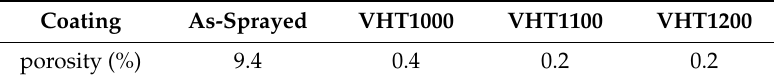
Table 3. The porosity of the as-sprayed coating and VHT